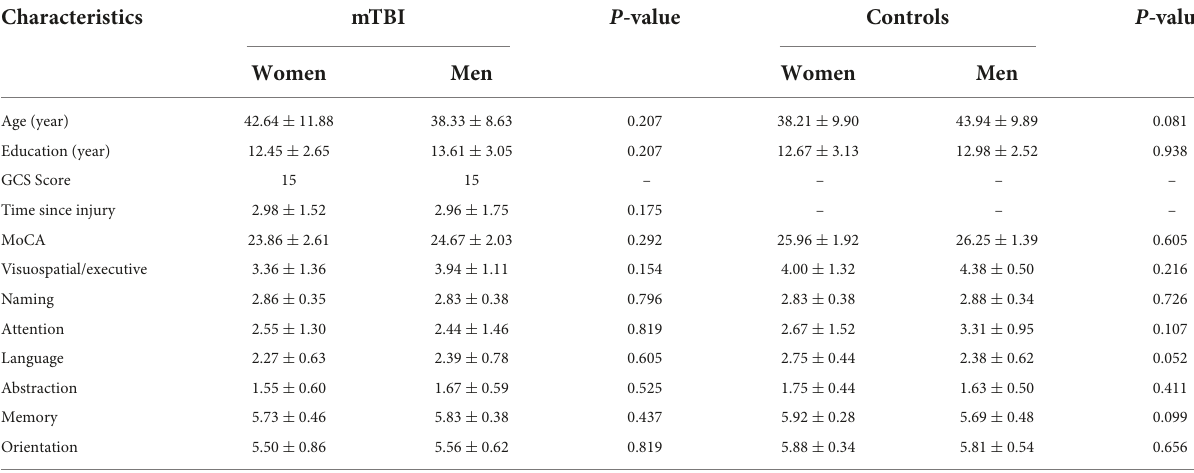
TABLE 2 Detailed demographic characteristics in mTBI patients and healthy controls. Characteristics